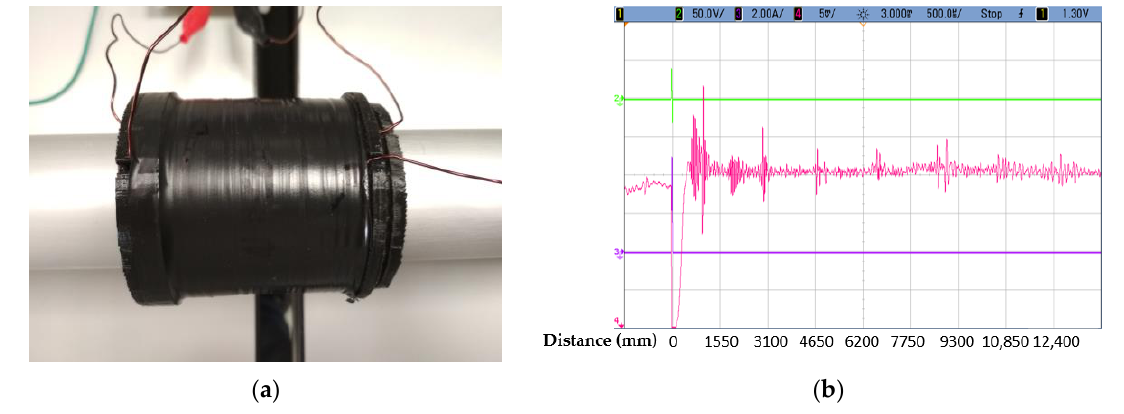
Figure 21. ( a ) Transducer with two encircling solenoids ( b ) Preliminary results with the new transducer under the same test conditions as those in Figure 18.